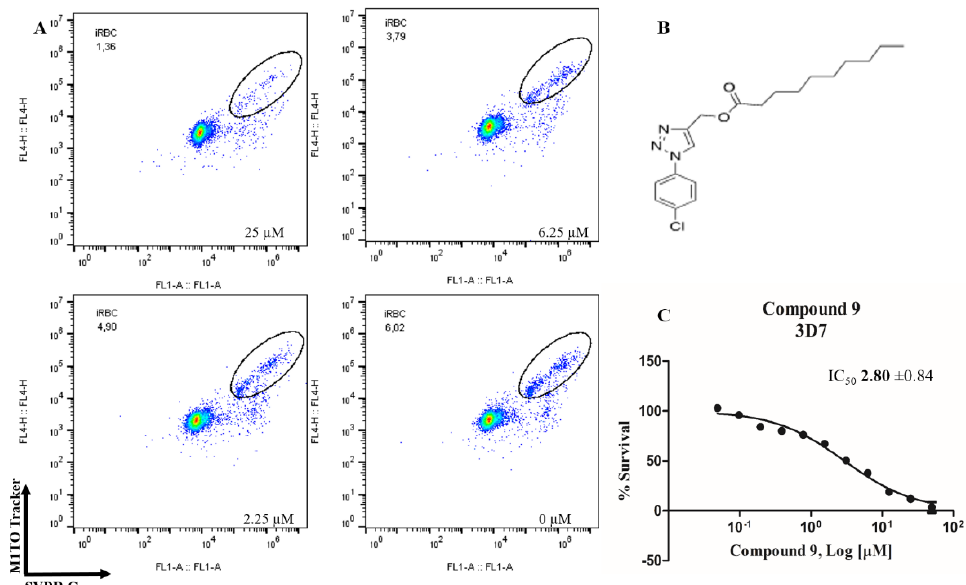
Figure 2. Determination of the antimalarial activity of the compound 9 . ( A ) Dot plots are shown for four different concentrations (25 µM, 6.25 µM, 2.25 µM and control) at the end of 72 h of incubation. ( B ) Chemical structure of the compound 9 . ( C ) Survival curve of the growth of P. falciparum in the presence of compound 9 at different concentrations (0.0488–50 µM).